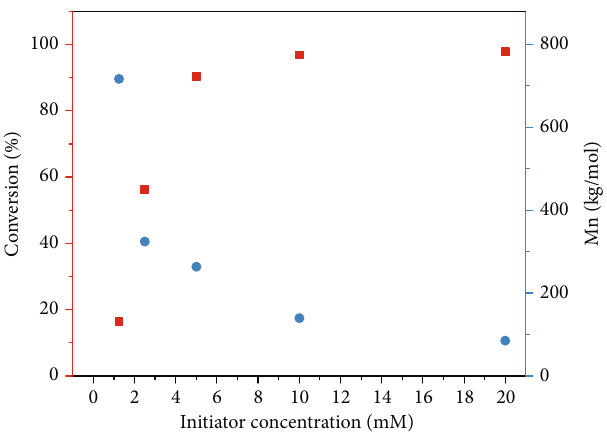
Figure 8: E ff ect of the initiator concentration on the monomer conversion and the number-average molecular weight ( W : O = 1 : 5 : 1 , T = 80 ° C, t = 20 min, and t = 40 1 2